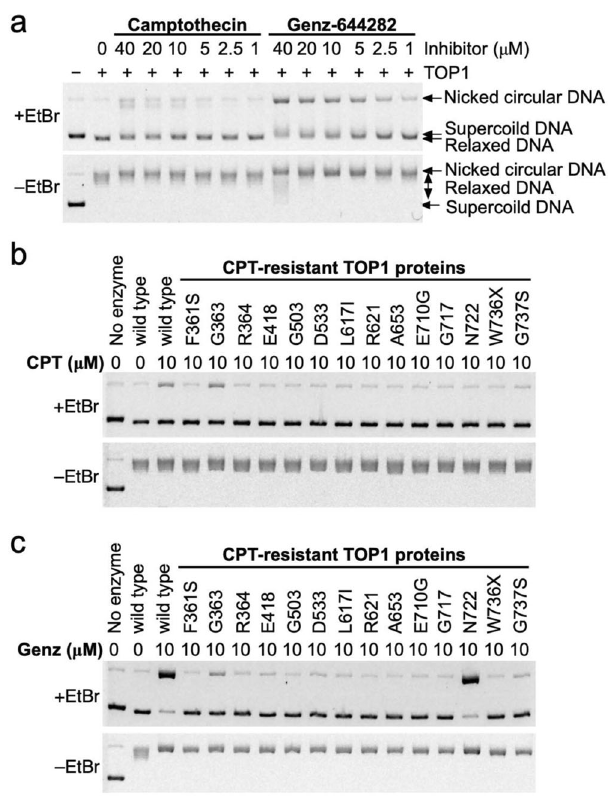
Fig. 3 Analysis of TOP1 inhibition by CPT and Genz in vitro. a The detection of DNA – TOP1 complex stabilised during the TOP1 reaction as nicked DNA by agarose gel electrophoresis in the presence of 0.5 μ g/mL ethidium bromide (EtBr). The wild-type TOP1 was treated with CPT and Genz. b The detection of DNA – TOP1 complex stabilised during the TOP1 reaction as nicked DNA by agarose gel electrophoresis. The wild-type and CPT-resistant TOP1 proteins were treated with 10 μ M CPT in the presence of 5 mM MgCl 2 . c The detection of nicked DNA by agarose gel electrophoresis. The wild-type and CPT-resistant TOP1 proteins were treated with 10 μ M Genz in the presence of Mg 2 +